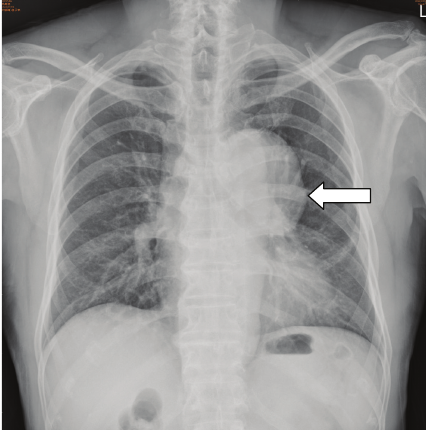
Figure 2: Chest radiography revealed a large bulging contour over- lying aorta and left hilar shadow.